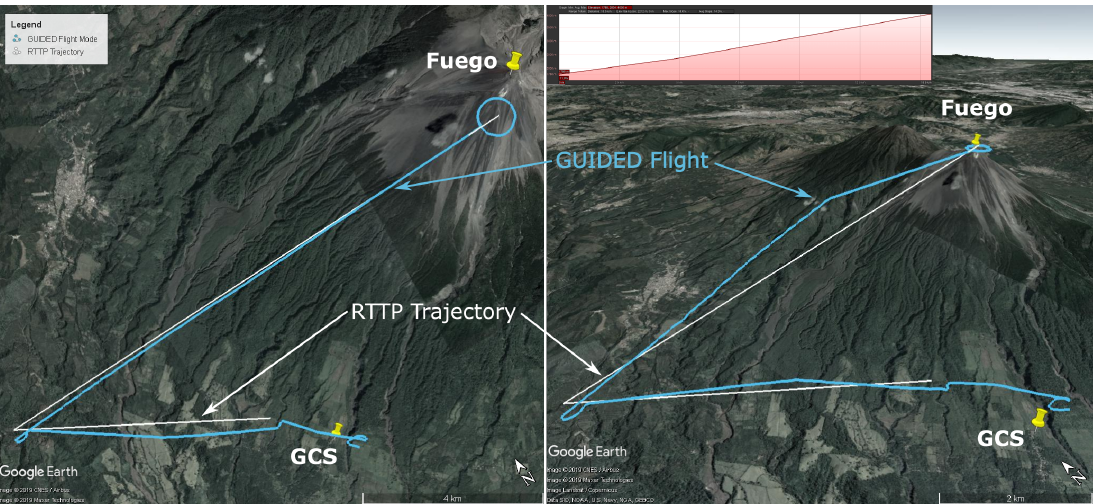
Figure 5. Flight B data: top down (left) and 3D (right) maps showing the Real Time Trajectory Planner solution (white) and the actual flight path (Guided: Blue) in Google Earth [29]. The elevation profile of the RTTP Trajectory is inset (top, right). For scale, the length of the longest leg here is 11.3 km.